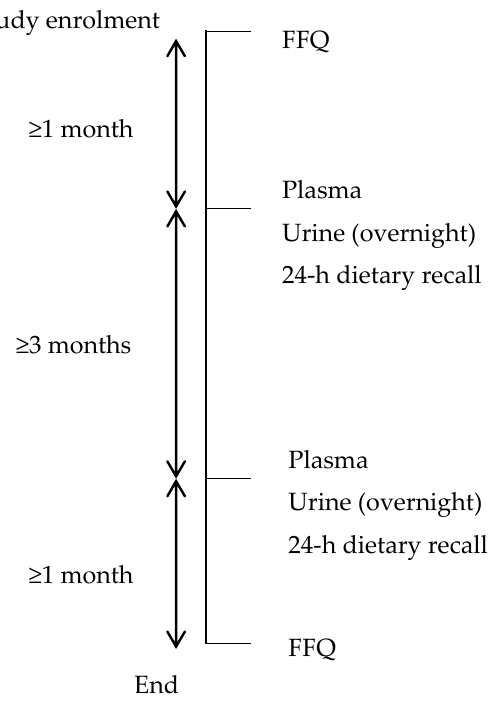
Figure 1. Sequence of validation study measurements.